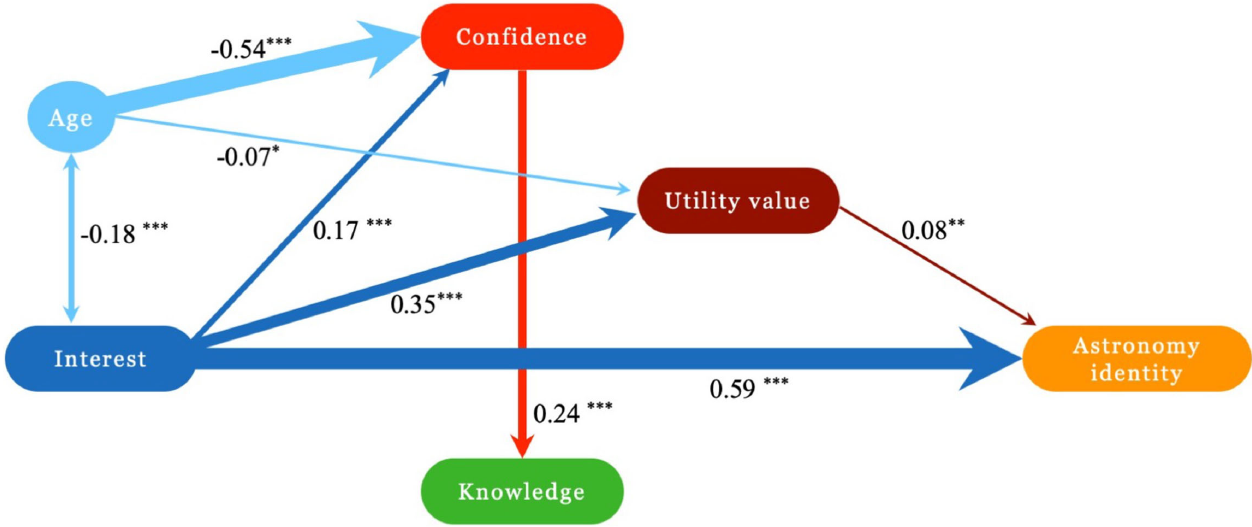
FIG. 4. Structural model of astronomy identity with age variable as a covariate. Regression weights are standardized. Two headed arrows represent item correlations. Each arrow with the line connecting two variables in the diagram indicates the direction of regression. * p < 0 . 05 ; ** p < 0 . 01 ; *** p < 0 . 001